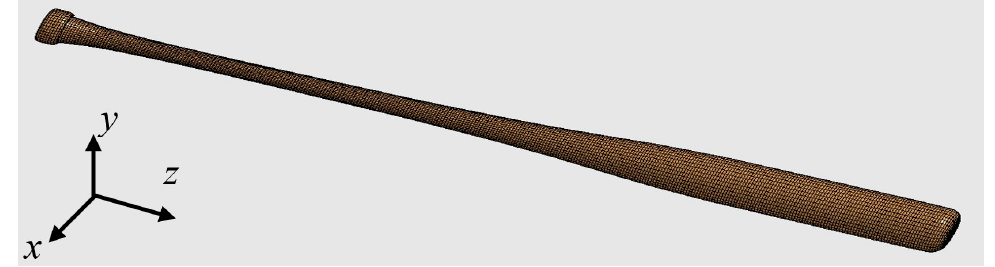
Figure 6. Finite element model of a C243 bat.